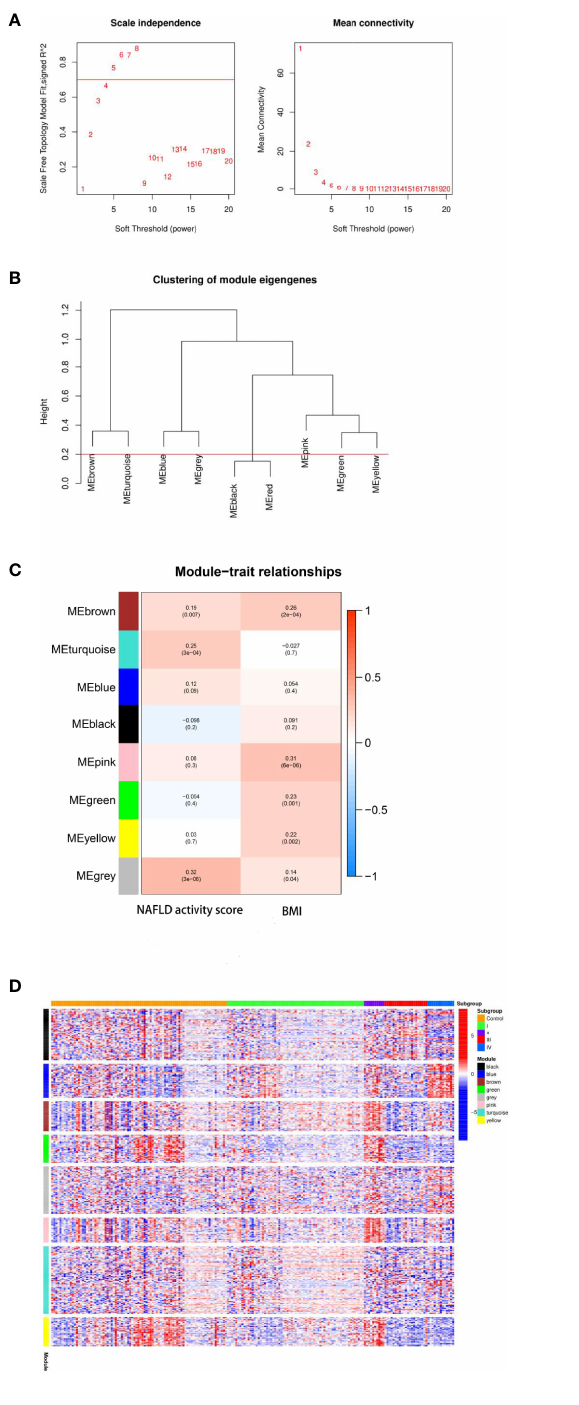
FIGURE 5 | Results of weighted gene co-expression network analysis (WCGNA). (A) Calculation of the soft threshold. The absolute value of the correlation coef fi cient was set to Cex1 = 0.7, and the threshold was chosen to be 5. (B) Clustering of module eigengenes. The minimum height of the merged modules was set to 0.20, and eight total co-expression modules were obtained. (C) Relationships between modules and clinical traits. The gray module was the most correlated with the non-alcoholic fatty liver disease (NAFLD) activity score (r = 0.32, P = 3e-06), whereas the pink module was the most correlated with the body mass index (BMI; r = 0.31, P = 6e-06). (D) Heatmap of the co-expression modules corresponding to the upregulated eigengenes in each molecular subtype. Expression levels of genes (vertical axis of the fi gure) in eight co-expression modules and the control sample are shown on the horizontal axis of the fi gure as follows: transcriptome I corresponds to the turquoise module; transcriptome II corresponds to brown, green, and pink modules; transcriptome III corresponds to black and gray modules; transcriptome IV corresponds to the blue